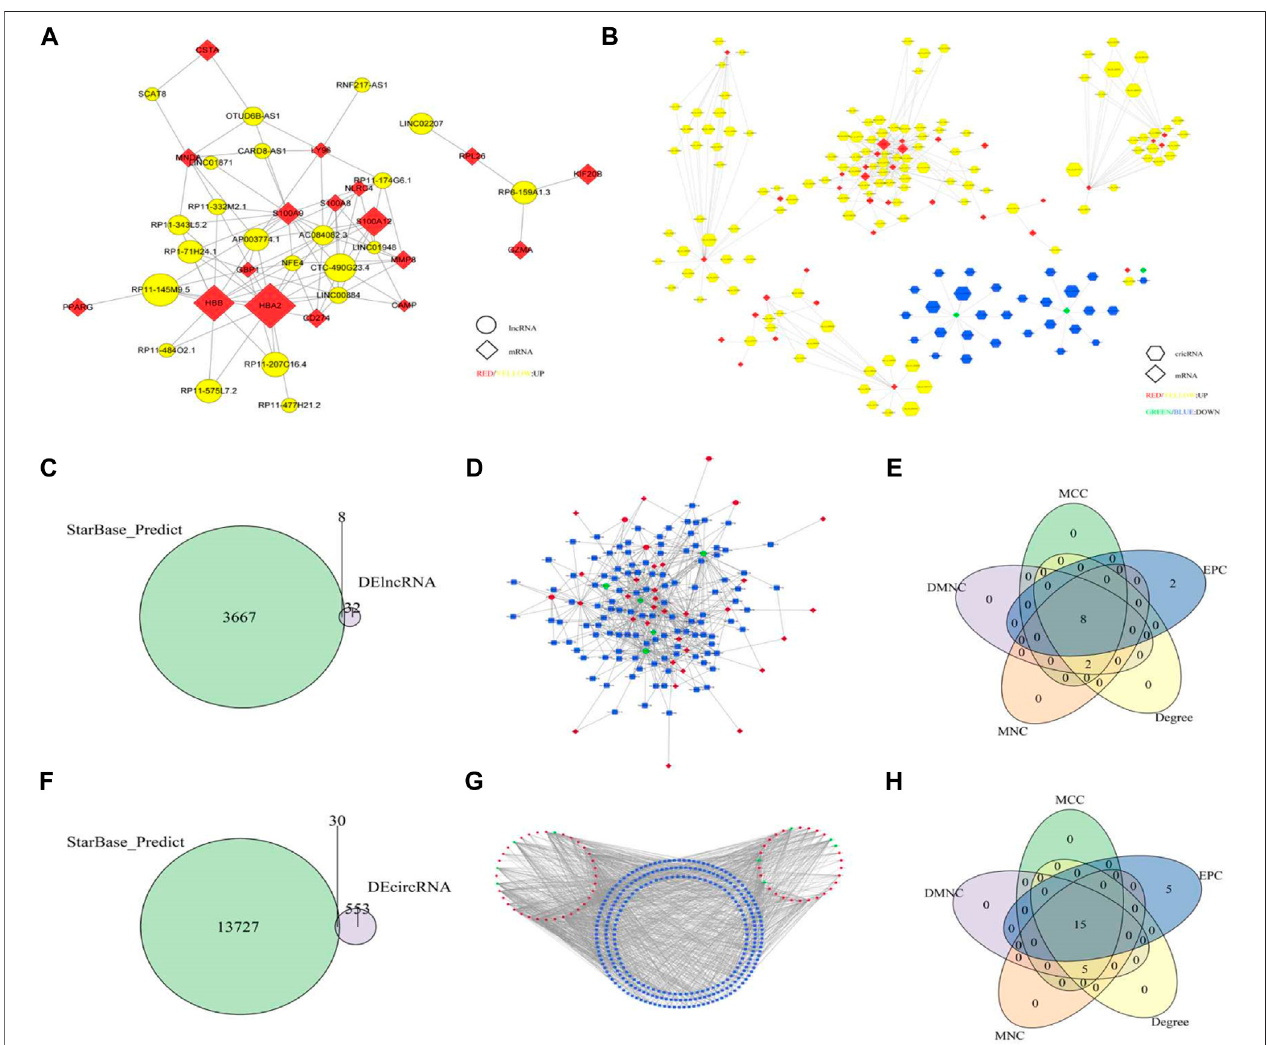
FIGURE 5 | (A) mRNA-lncRNA Co-expression network. The diamond is mRNA and the circle is lncRNA. Red and yellow indicate upregulation of mRNA and lncRNA, respectively, and the node size represents the multiple of change in the number of gene markers; (B) mRNA-circRNA co-expression network. The diamond is mRNA andthehexagoniscircRNA.Redand yellow indicate upregulation ofmRNAand up-regulation ofcircRNA, green andblue indicate downregulationofmRNAand circRNA, respectively, and node size represents multiple changes in gene expression; (C) Predicting the intersection of lncRNA and differential lncRNA; (D) lncRNA-miRNA-mRNA ceRNANetwork; (E) Thetop10hubgene; (F) PredictingtheintersectionofcircRNAanddifferentialcircRNA; (G) circRNA-miRNA-mRNAceRNA Network, (H) The top20 hub gene.